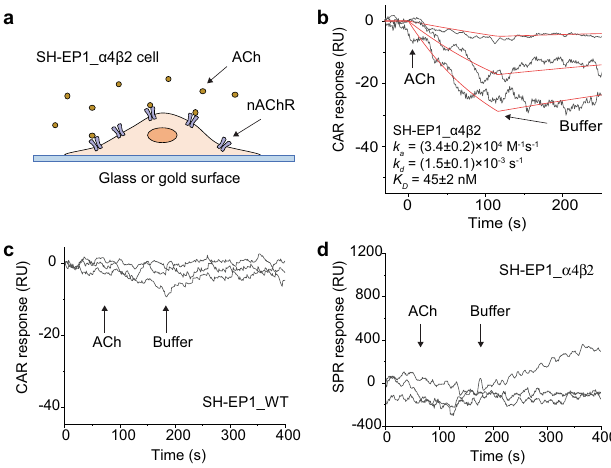
Fig. 5 Measuring acetylcholine binding to nicotinic acetylcholine receptor (nAChR) on SH-EP1_ α 4 β 2 cells. a SH-EP1_ α 4 β 2 cells were grown on a glass or gold surface for CAR or SPR measurements. The cells were fi xed with 4% paraldehyde before the measurement. b Acetylcholine (ACh) binding to SH-EP1_ α 4 β 2 cells measured by CAR. CAR angle was set at 61.6 degrees with a sensitivity of 112 RIU − 1 . The binding kinetic curves (black) were obtained by averaging the CAR response of seven cells and globally fi tted to the fi rst-order kinetics (red) (see Supplementary Figure 12b for the response of individual cells). Acetylcholine concentrations: 25 nM, 100 nM, and 200 nM. c Control experiments using wild-type SH-EP1 cells (SH- EP_WT), which have no nAChR. Acetylcholine and PBS buffer fl owed to the cells as indicated by the arrows. No clear CAR response was observed (see Supplementary Figure 12d for individual cells). Acetylcholine concentrations: 50 nM, 100 nM, and 200 nM. d Measuring acetylcholine binding to SH-EP1_ α 4 β 2 cells using SPR. No response was observed due to insuf fi cient sensitivity of SPR (see Supplementary Figure 12f for individual cells). Acetylcholine concentrations: 50 nM, 100 nM, and 200 responsible for neurotransmission and drug addiction 32 . nAChR was expressed on brain neuroblastoma SH-EP1 cells by trans-